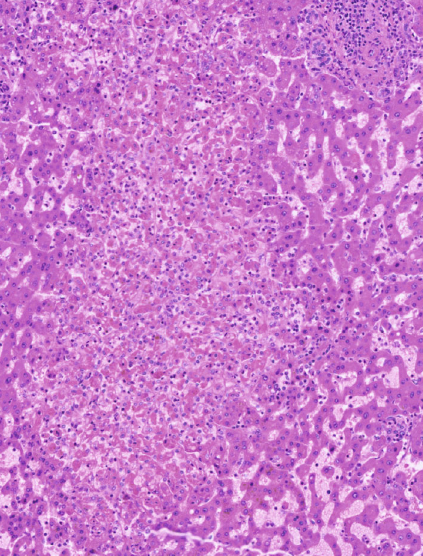
Figure 4: In fl ammatory remodeling and microabscesses of the liver